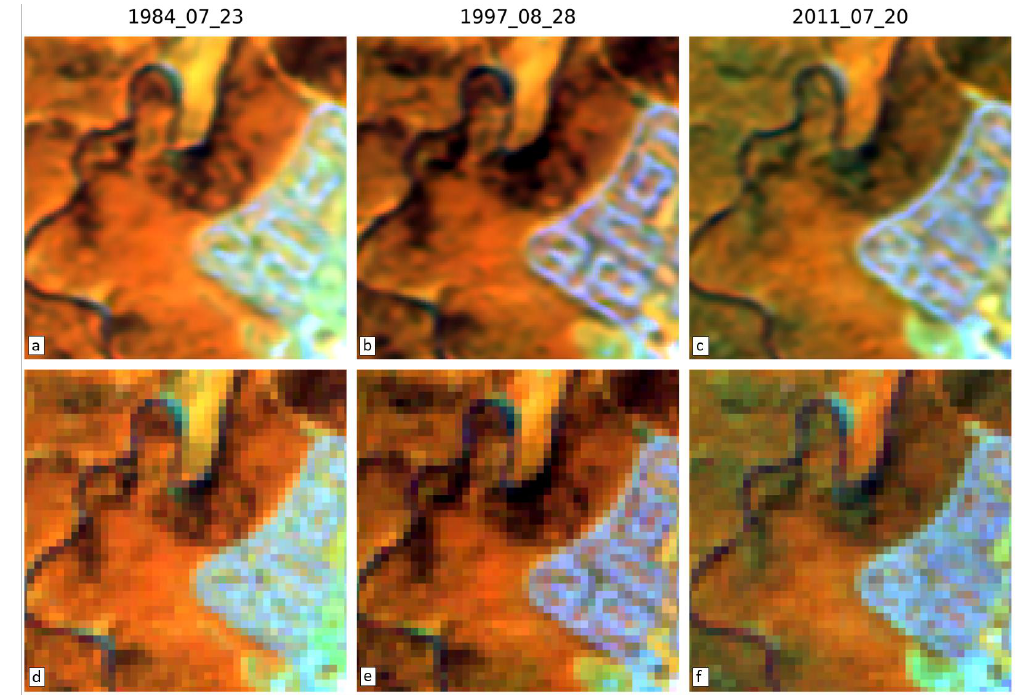
Figure 5. Example temporal extension result for a boreal mixedwood forest. ( a,b,c ) is the spatially enhanced result and ( d,e,f ) is the original Landsat.